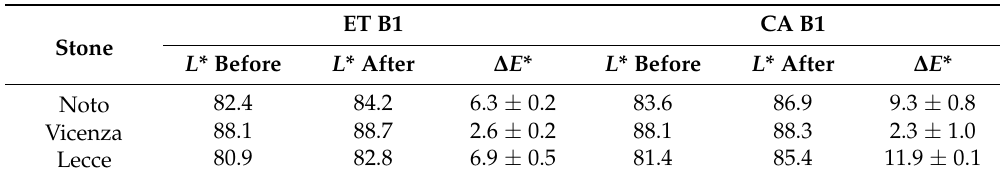
Table 3. Colorimetric coordinates L * and relative color differences ∆ E * generated by consolidating products with both application procedures.